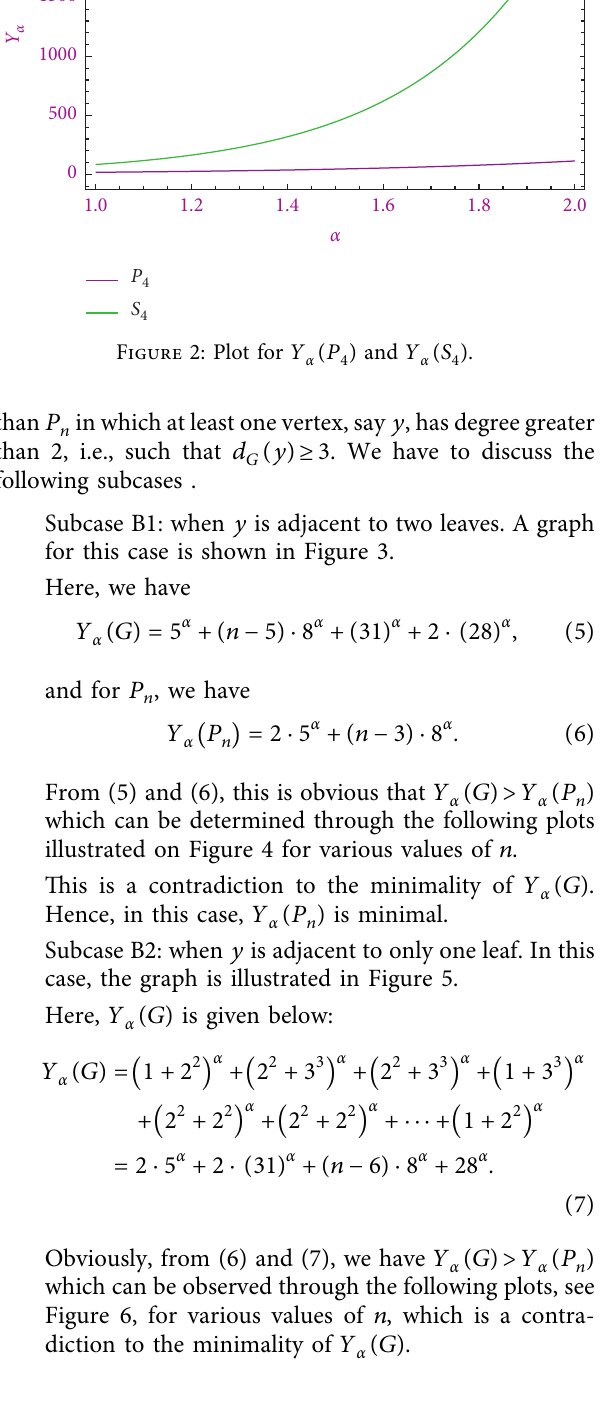
and a star S . 4 4 and S 4 4